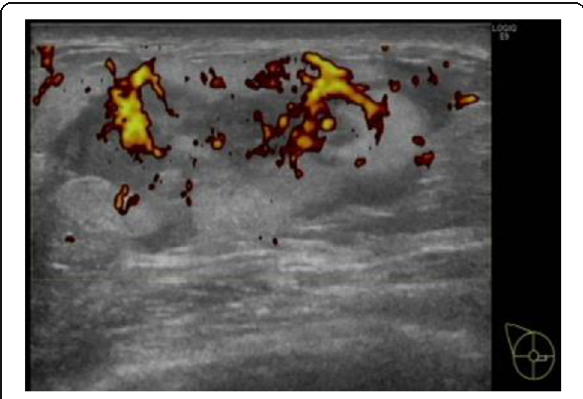
Fig. 1 Doppler sonography showed hypervascularization of the tumor